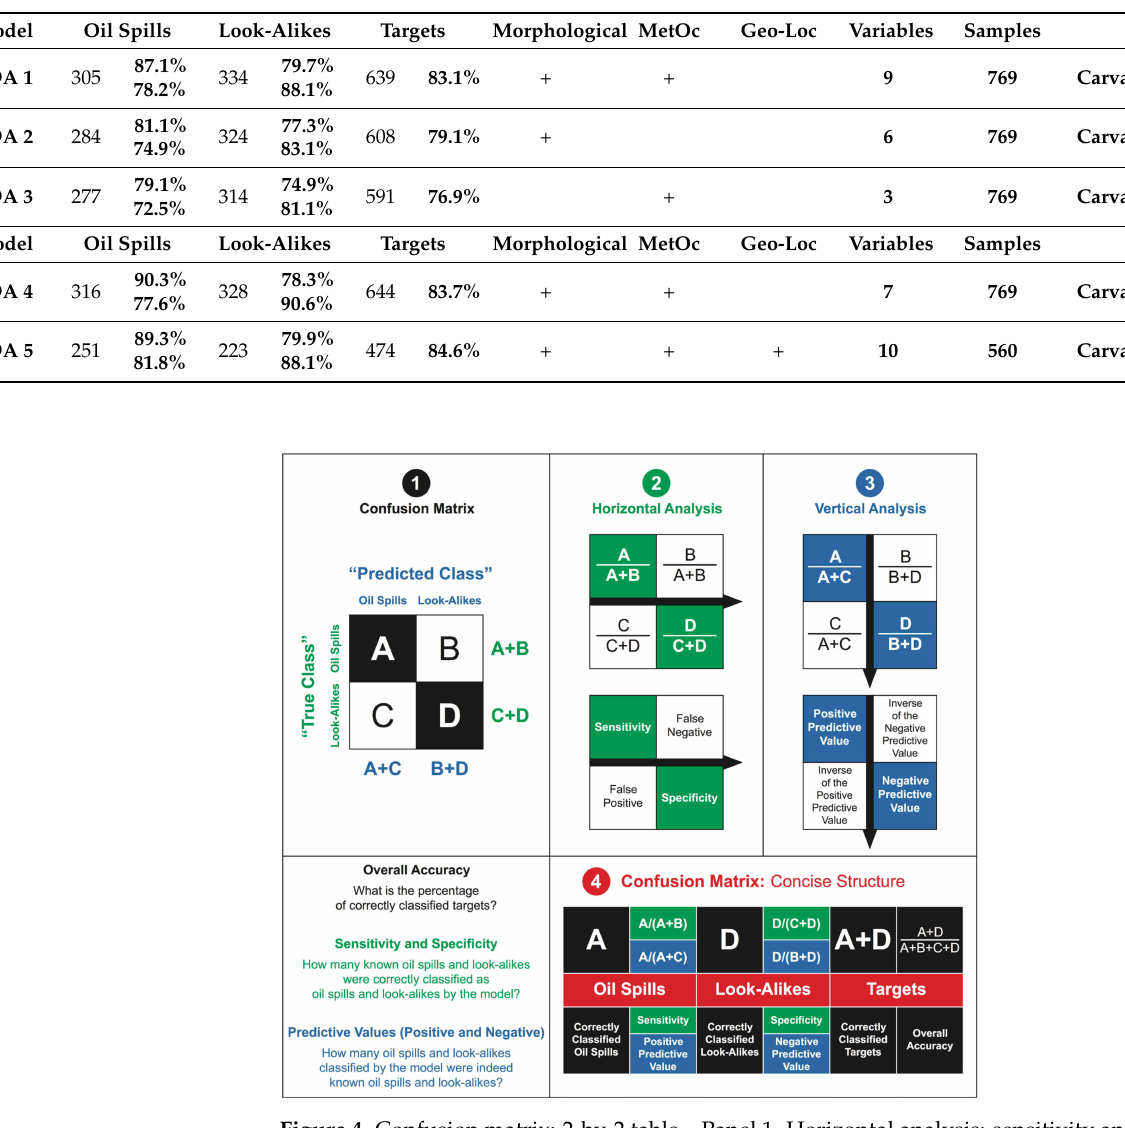
Figure 4. Confusion matrix: 2-by-2 table—Panel 1. Horizontal analysis: sensitivity and specificity— Panel 2. Vertical analysis: predictive values (positive and negative)—Panel 3. Concise confusion matrix structure—Panel 4. Correctly classified targets: A + D. Correctly classified oil spills (A) and look-alikes (D). Misclassified oil spills (C) and look-alikes (B). True class: known oil spills (A + B) and known look-alikes (C + D). Predicted class: model classified oil spills (A + C) and model